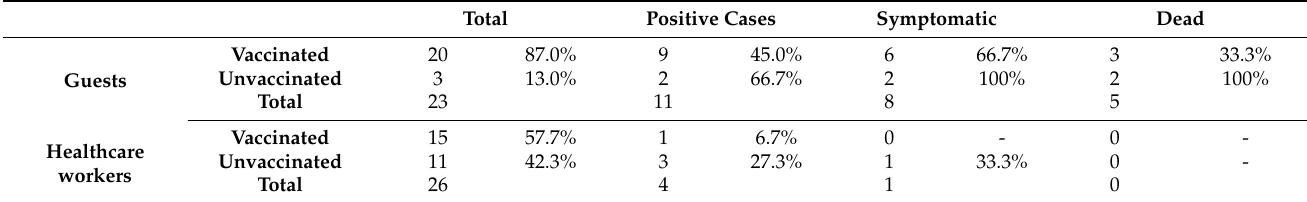
Table 1. Summary of outcomes of vaccinated and unvaccinated residents and healthcare workers who tested positive for SARS-CoV-2.